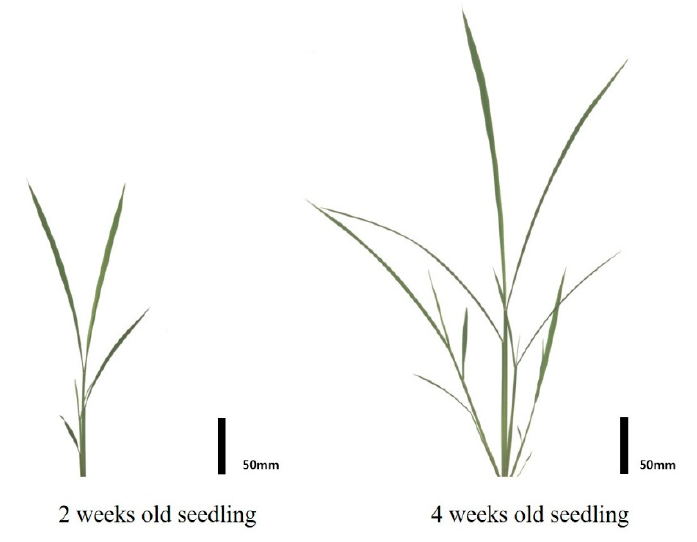
Figure 2. Phenotype of two and four week-old plants.